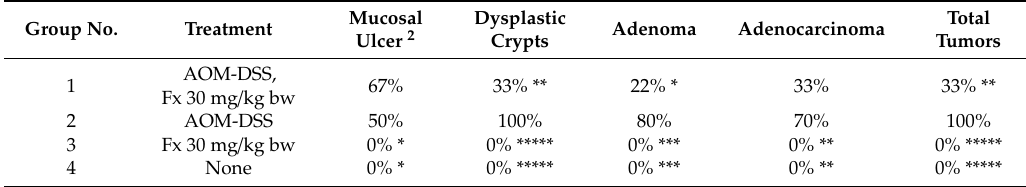
Figure 1. Body weight, tumor number and size in colitis-induced carcinogenesis model mice. ( A ) Chemical structure of fucoxanthin (Fx). ( B ) Experimental protocol for AOM / DSS induced colorectal carcinogenesis. Fx-oil was administrated to groups 1 and 3 at 30 mg Fx / kg bw every 1–3 days during the final 3 weeks before sacrifice (red arrows). The control groups with or without AOM / DSS treatment were given the equivalent volume ( µ l) of control-oil (Fx-free) (black arrows). ( C ) Body weight changes during the period of Fx administration. ( D ) Tumor number. Means ± SE (Fx, n = 13; control, n = 15). ( E ) Estimated tumor size. Means ± SE (Fx, n = 38; control, n = 101). The parentheses are 95% confidence intervals. Significant di ff erences in tumor number ( D ) and estimated tumor size ( E ) were performed by Wilcoxon rank sum test (vs. group 2). * p < 0.05. AOM: Azoxymethane DSS: dextran sodium sulfate. Table 1. Incidence (%) of colonic lesions. 1.